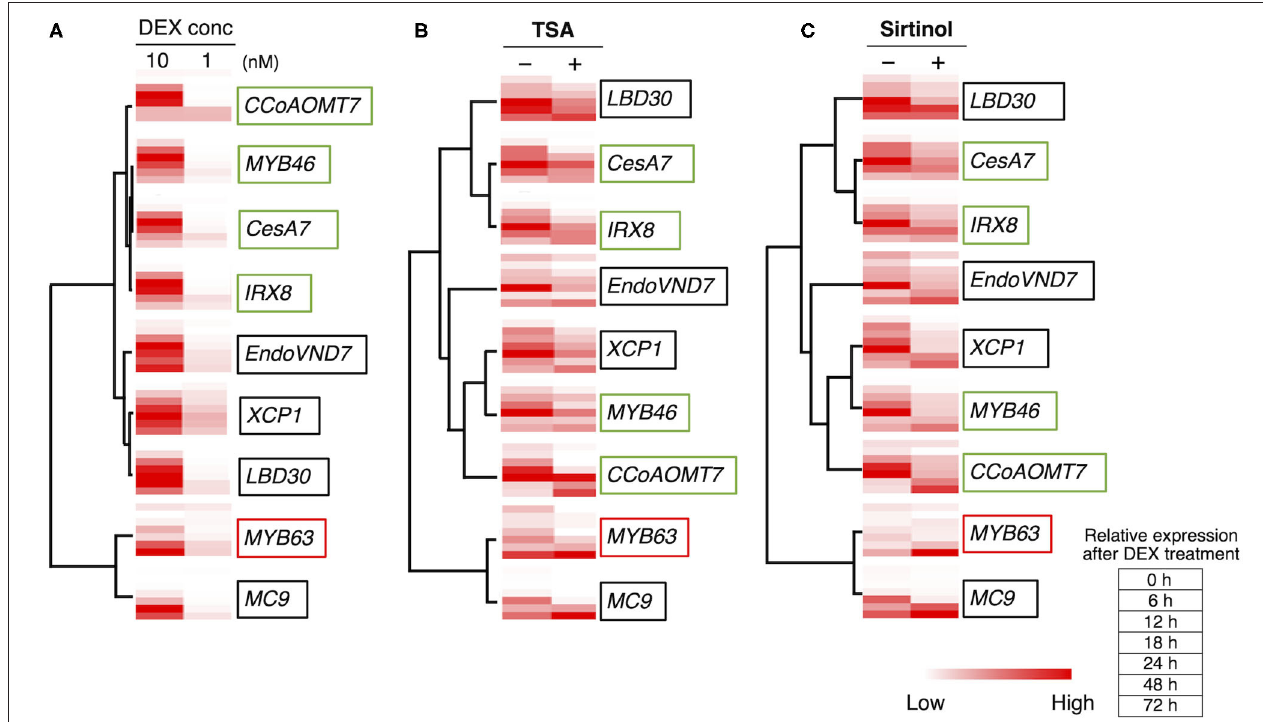
FIGURE 4 | Hierarchical clustering analysis of the expression patterns of the genes downstream of VND7. The hierarchical clustering analysis was performed using the normalized quantitative RT-PCR data presented in Hirai et al. (2019) (A) , in Figure 3 (B) , and in Supplementary Figure 3 (C) . Each column shows the relative expression level of each gene at each time point of DEX treatment by color